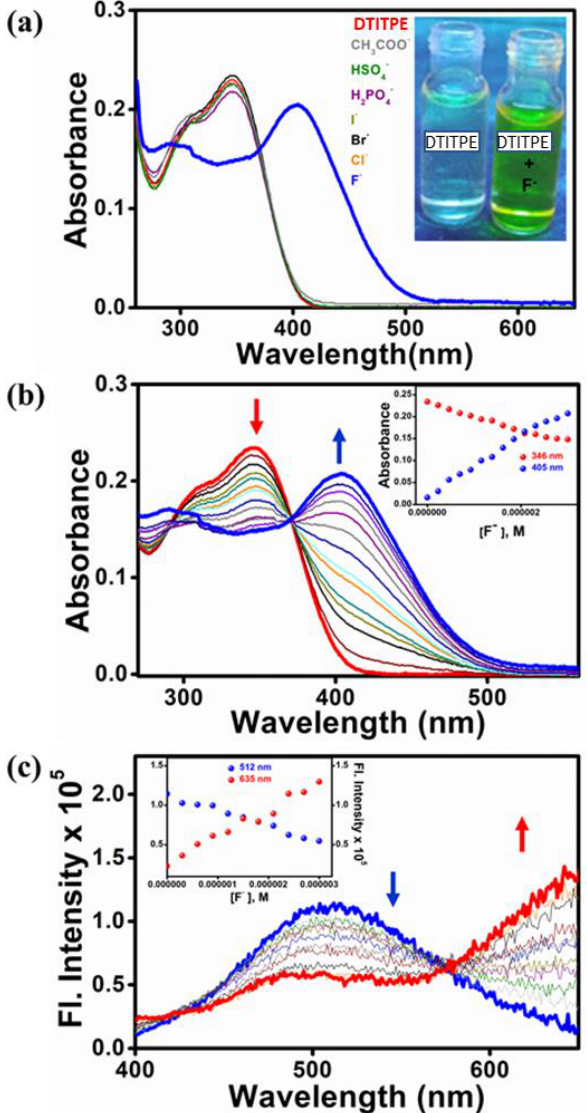
Figure 3. ( a ) UV-vis. spectra of a THF solution of DTITPE (3 × 10 −6 M) in the absence and presence of various anions. ( b ) UV-vis. titration spectra of DTITPE in THF (3 × 10 −6 M) upon incremental addition of TBAF solutions (2.31 × 10 −7 to 5 × 10 −6 M). ( c ) Fluorescence emission titration spectra of DTITPE (3 × 10 −6 M) upon incremental addition of TBAF (3 × 10 −7 to 9 × 10 −6 M).